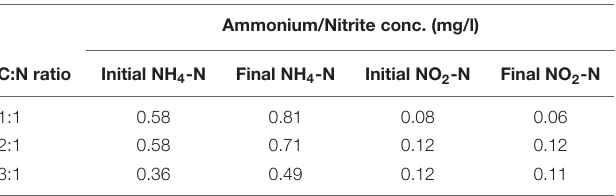
TABLE 1 | Ammonium and nitrite concentrations in mg/l at the beginning and end of the flask experiment, at C:N ratios of 1:1, 2:1, and 3:1.